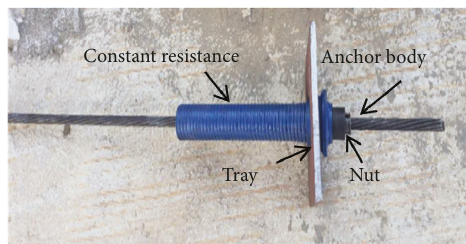
Figure 12: The constant resistance large deformation anchor cable.